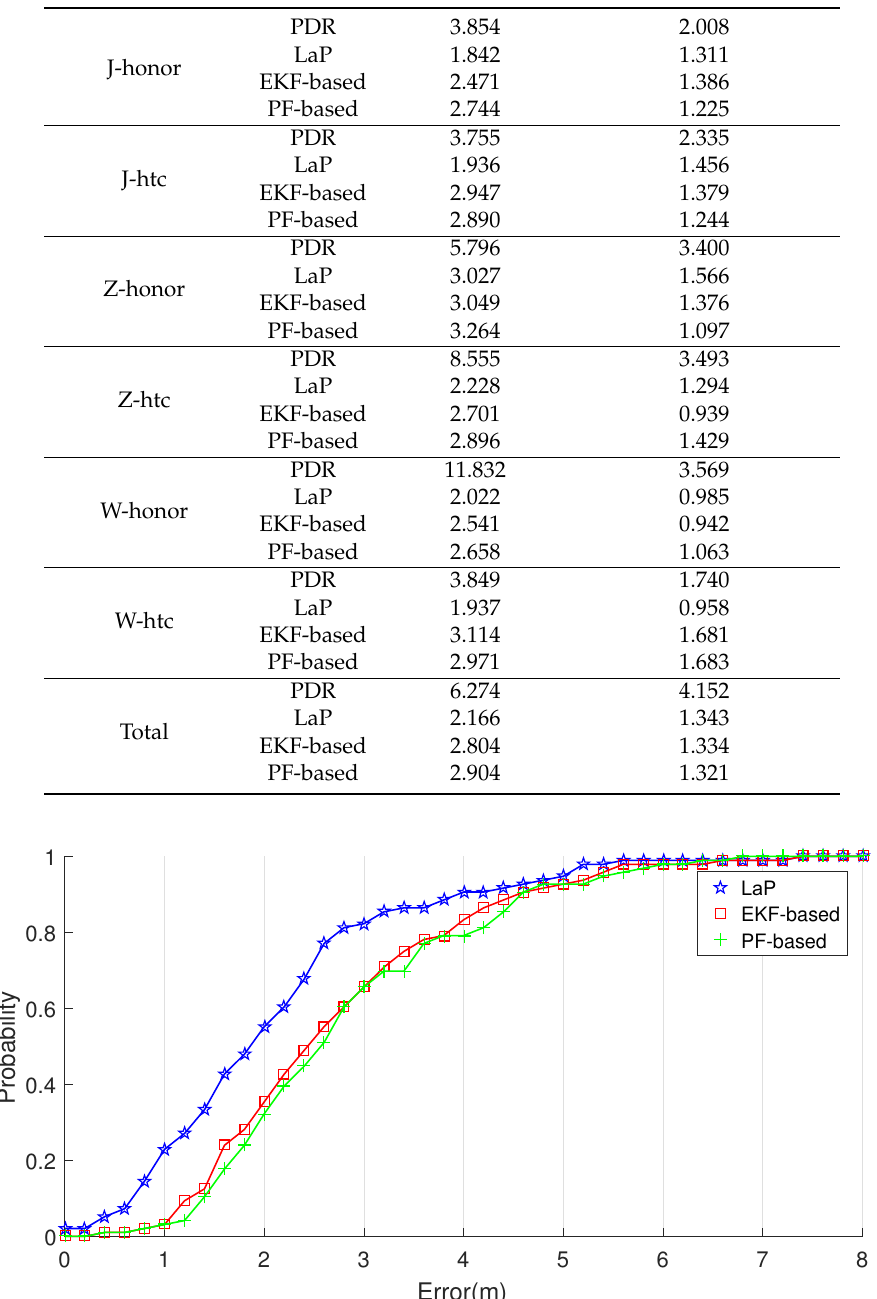
Figure 15. Localization error CDF of LaP and two other